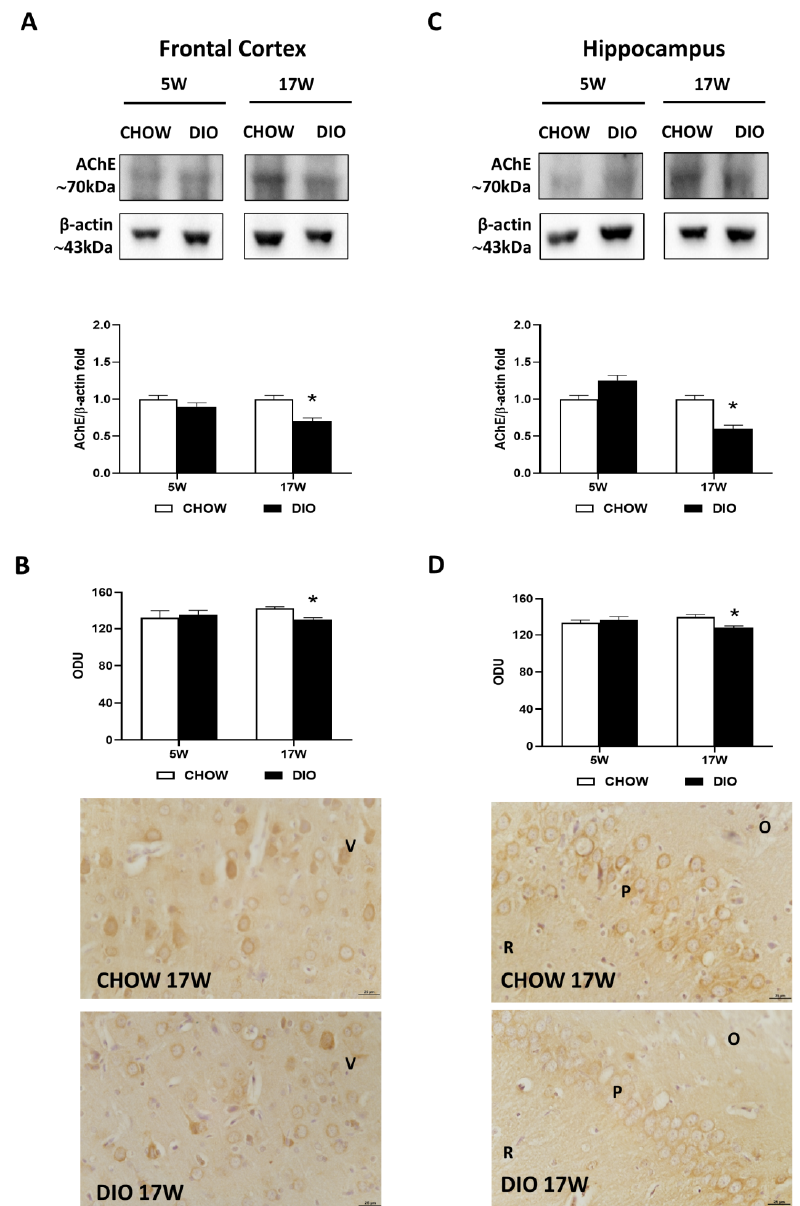
Figure 2. Western blot and immunohistochemistry of acetylcholinesterase (AChE). Samples of the frontal cortex ( A ) and hippocampus ( C ) from rats fed with a standard diet (CHOW rats) and high- fat diet (DIO rats) for 5 and 17 weeks were immunoblotted with anti-AChE. Graphs report the densitometric data with CHOW rats as control, and β -actin was used as a reference loading protein. AChE immunoreaction intensity in the frontal cortex ( B ) and the hippocampus ( D ) from CHOW and DIO rats after 5 and 17 weeks of a high-fat diet was measured in optical density units (ODUs). Data are mean ± S.E.M. * p < 0.05 vs. age-matched CHOW rats. CHOW rats 5 weeks n = 8; DIO rats 5 weeks n = 8; CHOW rats 17 weeks n = 8; DIO rats 17 weeks n = 9. Representative pictures of CHOW and DIO frontal cortex ( B ) and hippocampus, CA2 subfield, ( D ) after 17 weeks of diet. V, fifth layer of frontal cortex; O, stratum oriens ; P, pyramidal neurons; R, stratum radiatum . Scale bar: 25 μ m.